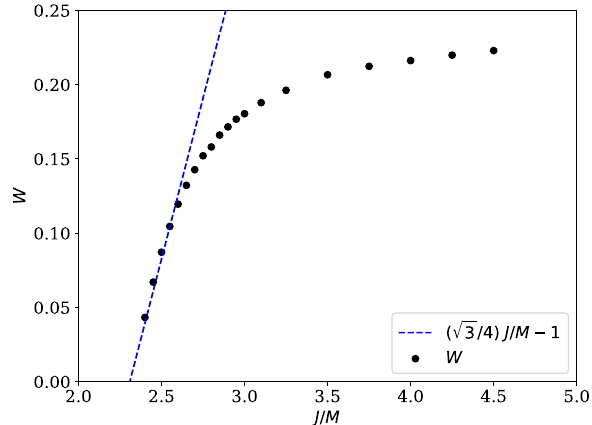
Figure 15 . Growth rate W of the dominant unstable mode of the black bars as a function of J/M . The rates are computed by linear regression of the curves in figure 14 at a value of the deformation 2 . The blue dashed line is the black string approximation to a black of 10 −